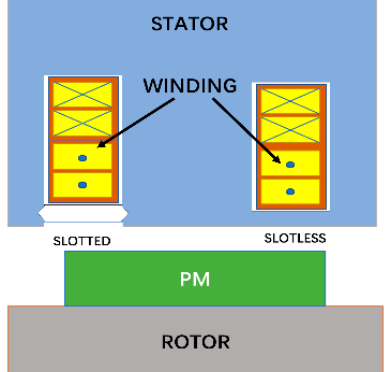
Figure 1. Motor stator with and without slot.